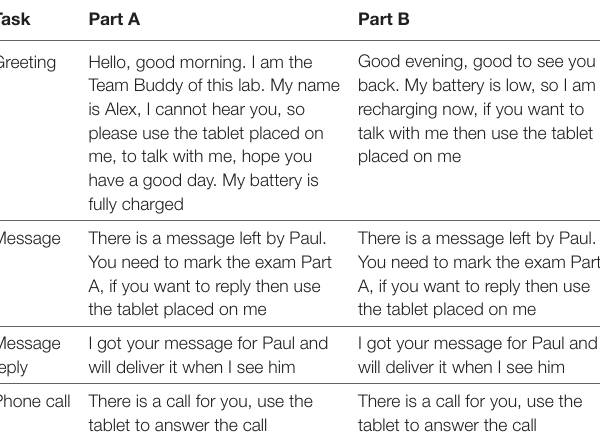
TaBle 1 | Condition 1: neutral verbal